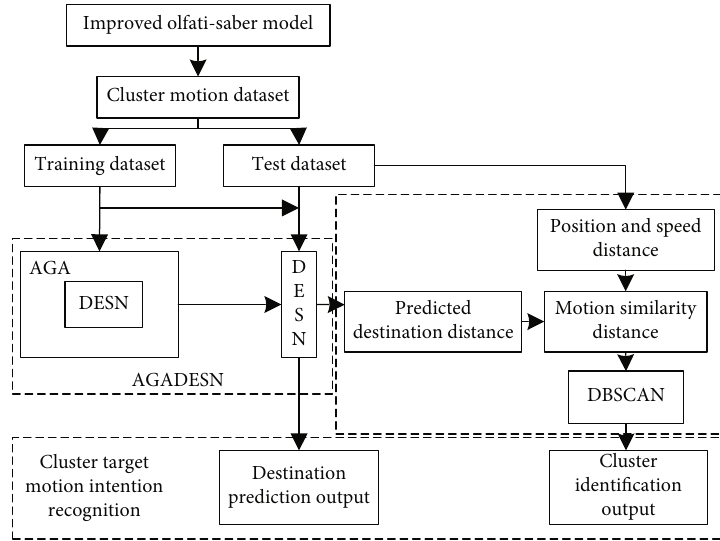
Figure 1: Intention recognition method process.